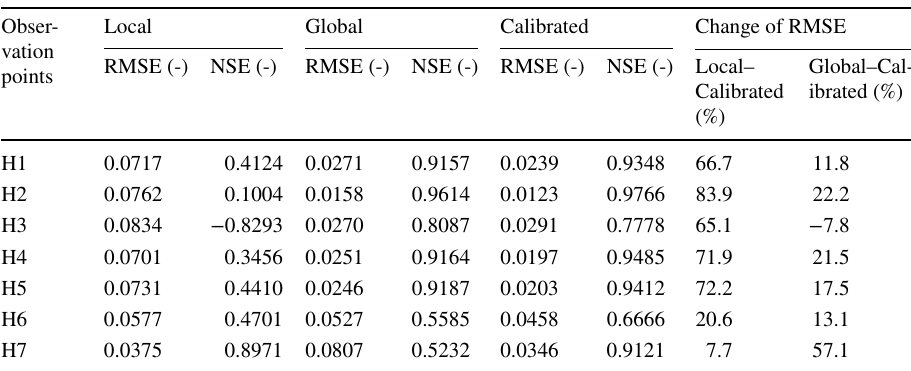
Table 2 Model fit to observation regarding water content by using hydraulic soil parameters originating from local, global and calibration measurements—soil 1